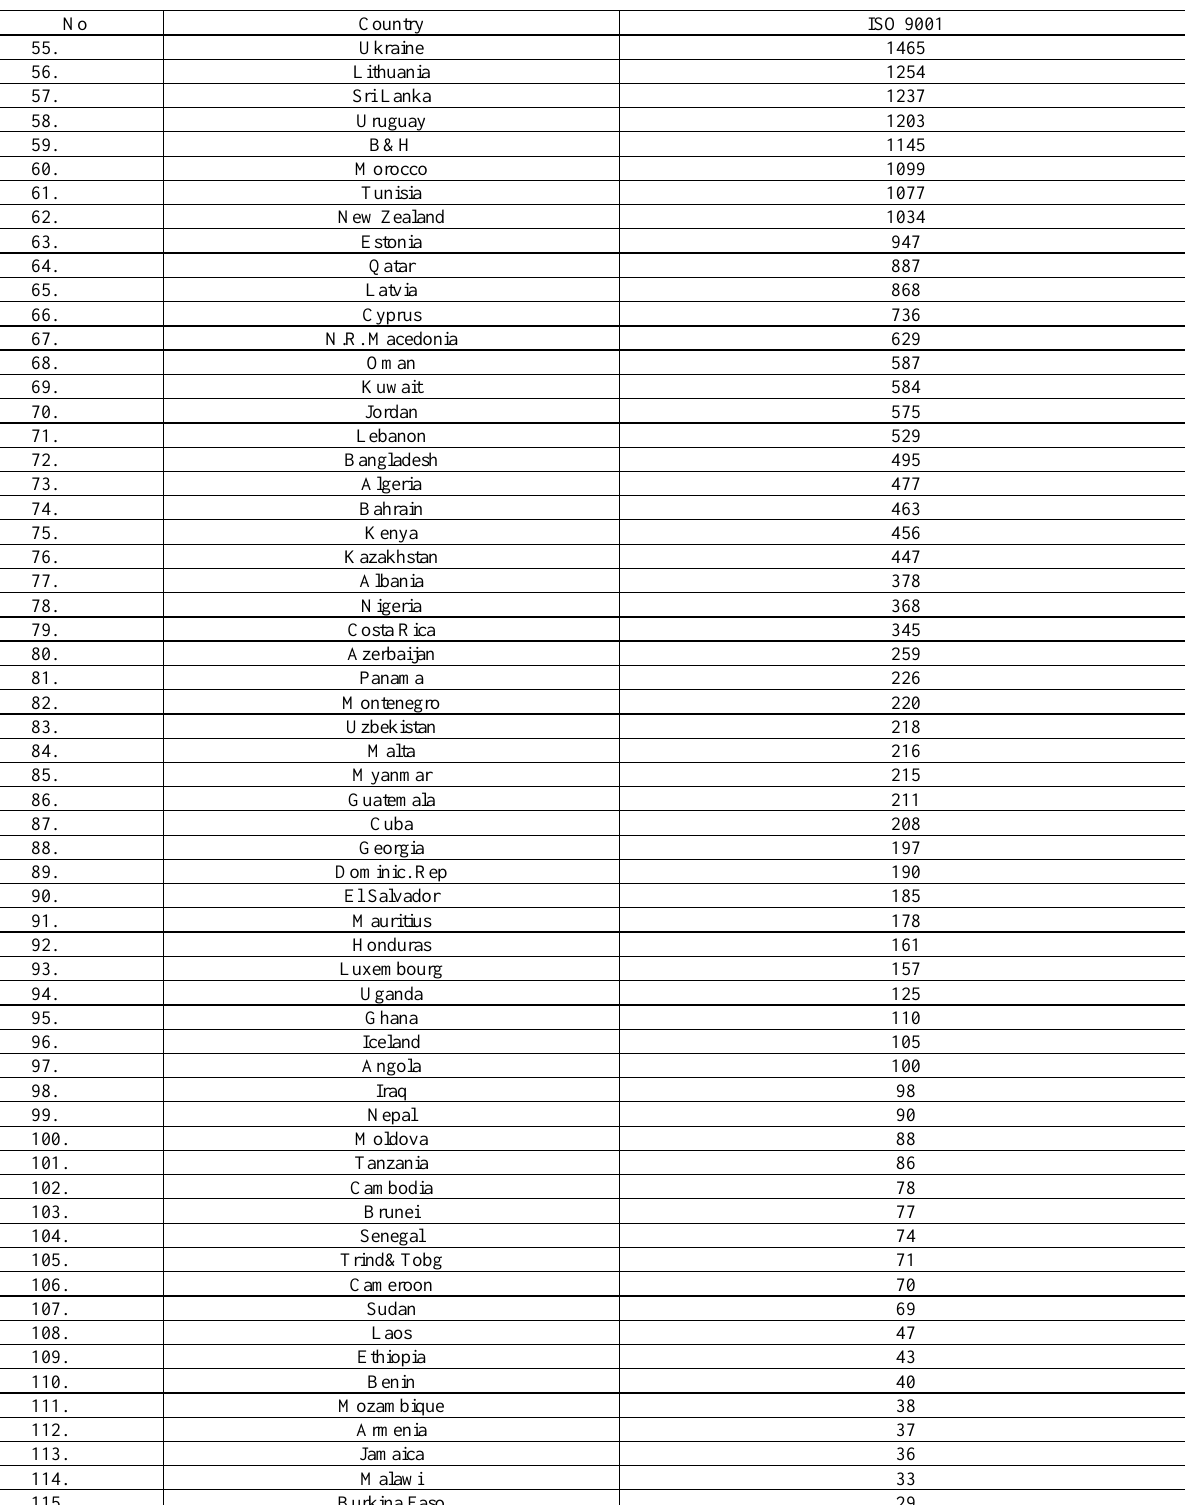
Table 2 (cont.). List of countries for ISO 9001 certificates issued based on the higher value of ISO 9001 certificates issued (136 countries worldwide, drawn from the author of this paper from the ISO table of the list of countries per alphabetic order, using